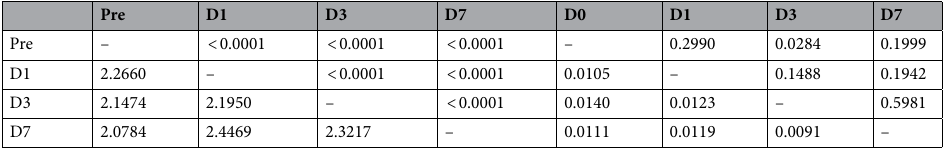
Table 1. Differences in the facial shapes between preoperative (Pre) and postoperative condition (D1, D3, D7) in Japanese macaques. Mahalanobis distances (left) & Procrustes distances (right): p-values (above); distances between groups (below).